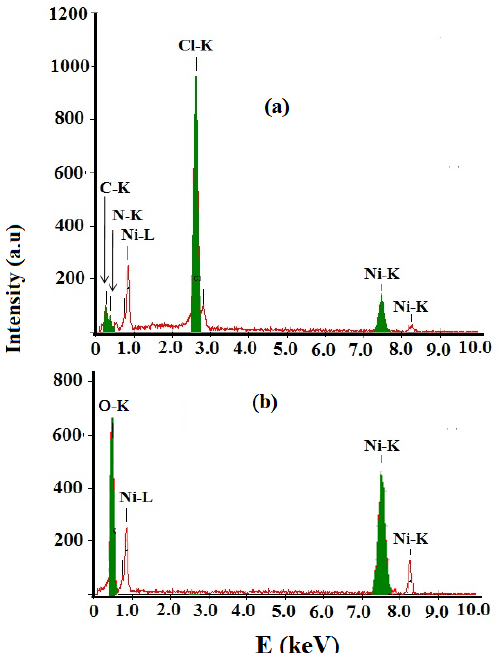
Figure 5. EDX spectra ( a ) NiCl and ( b ) NiO